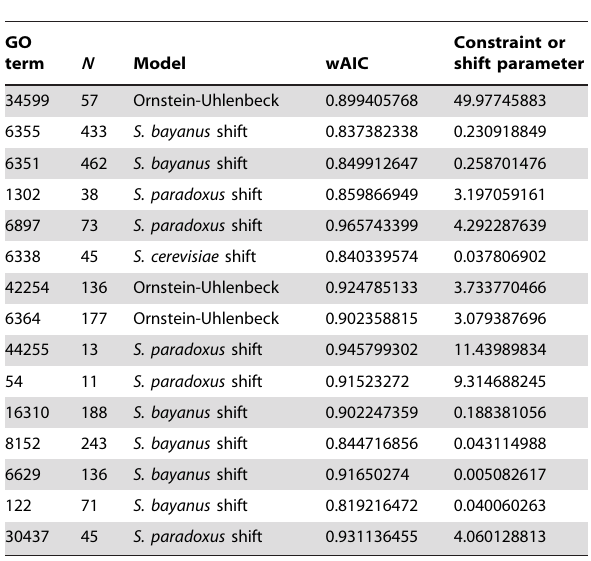
Table 1. Top-scoring fitted models of cis -regulatory evolution in yeast pathways from experimental expression